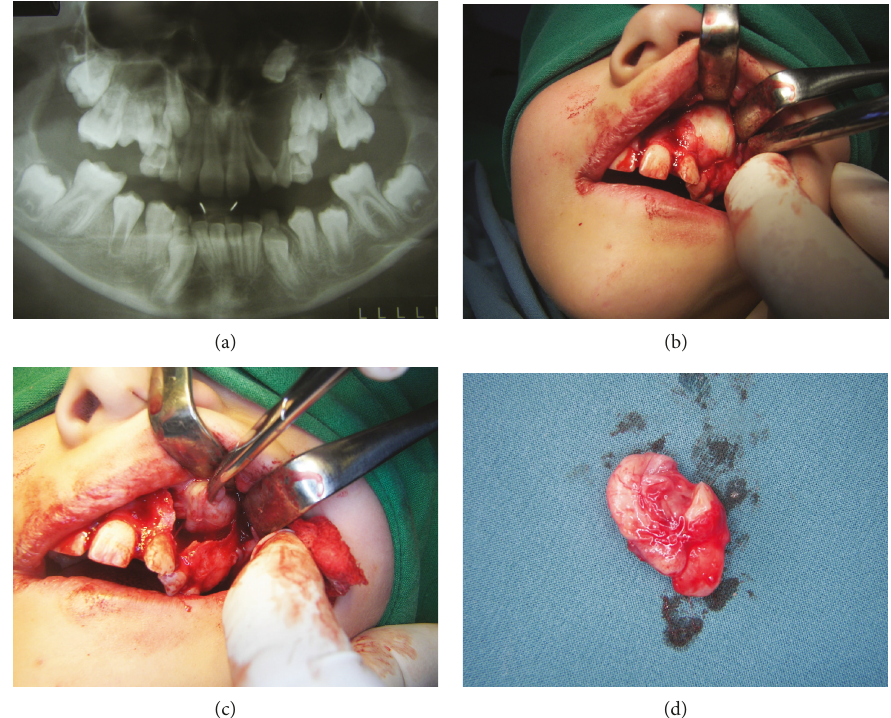
Figure 1: (a) Ellipsoid RTG radiolucency in the left maxilla which diverges the roots of adjacent teeth, in the upper part of which there is a retained permanent canine. (b) Opalescent-white cyst sheath after the mucoperiosteal fl ap has been raised. (c) Enucleation of a cystic capsule. (d) Macroscopic preparation of exterminated keratocysts together with a retained canine